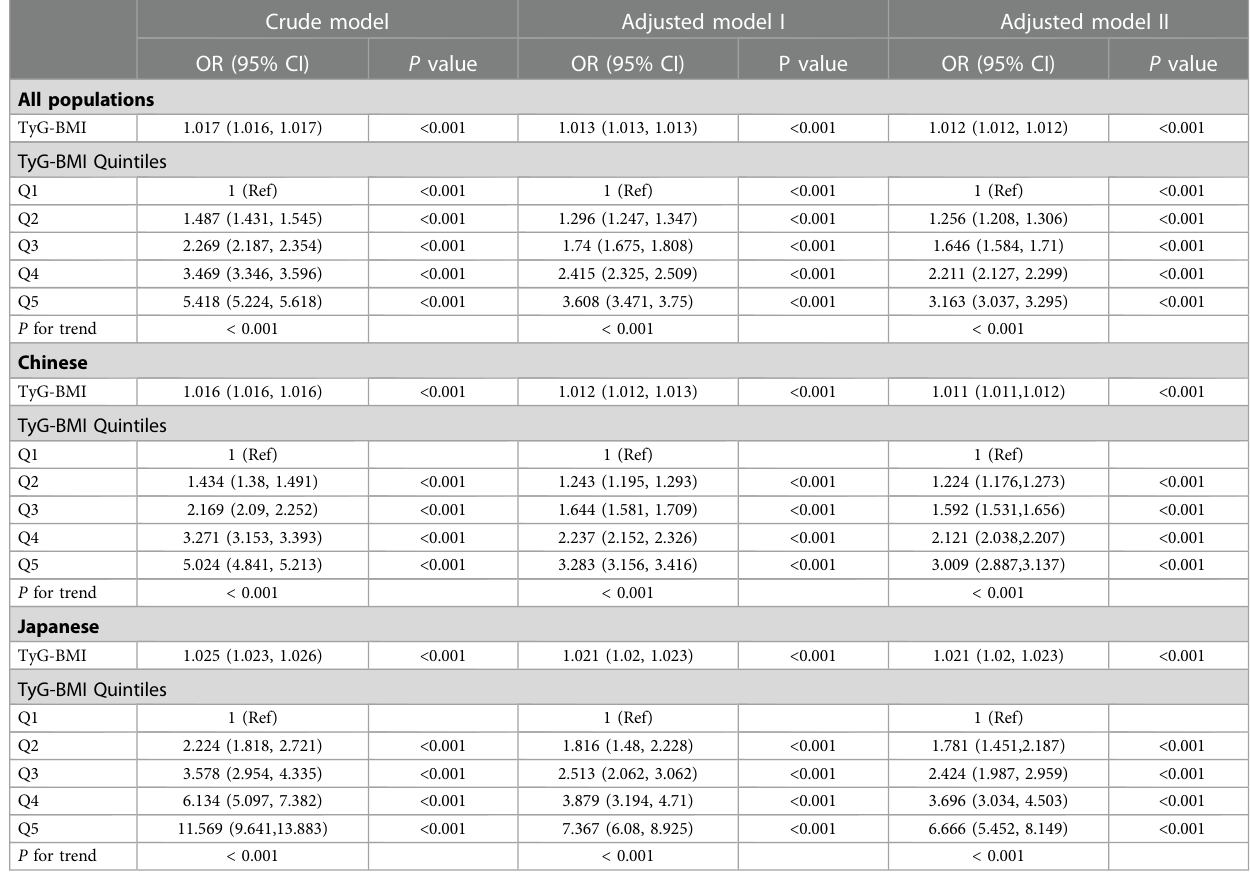
TABLE 2 Logistic regression analysis of the relationship between TyG-BMI and